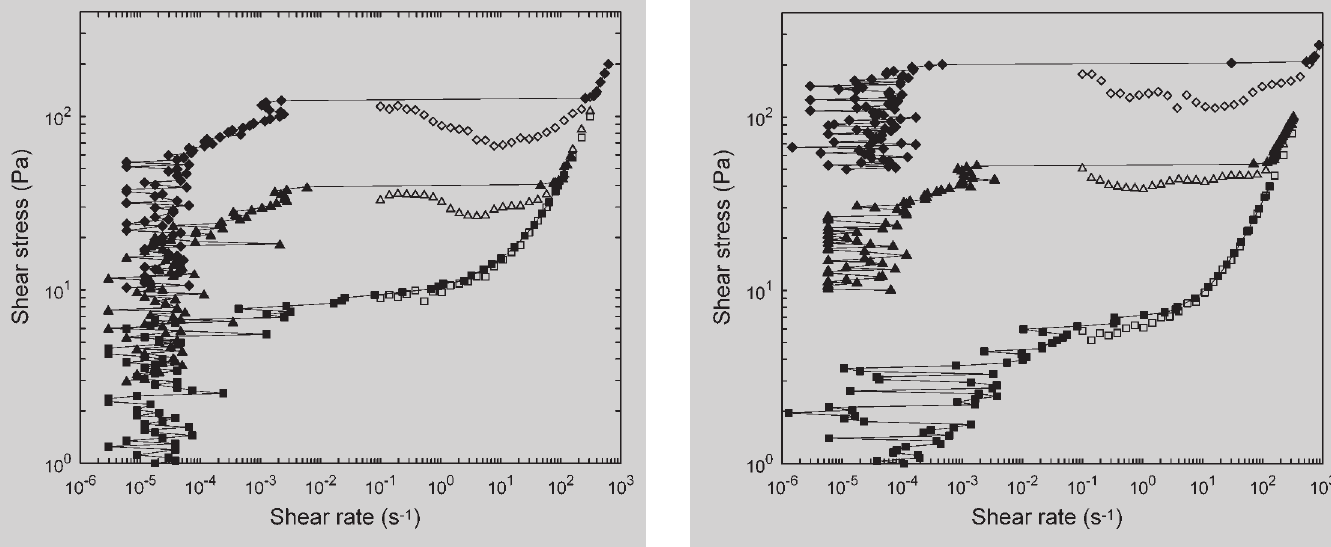
Figure 2: Data from controlled shear- stress (full symbols) and controlled shear-rate (open symbols) experiments of suspension of uncoated silica (Electric field strength [kV mm -1 ] : · 0, Û 1, Ì 2). Figure 3: Data from controlled shear- stress (full symbols) and controlled shear-rate (open symbols) experiments on the suspension of silica coated with PANI (Symbols denoted as in Fig.